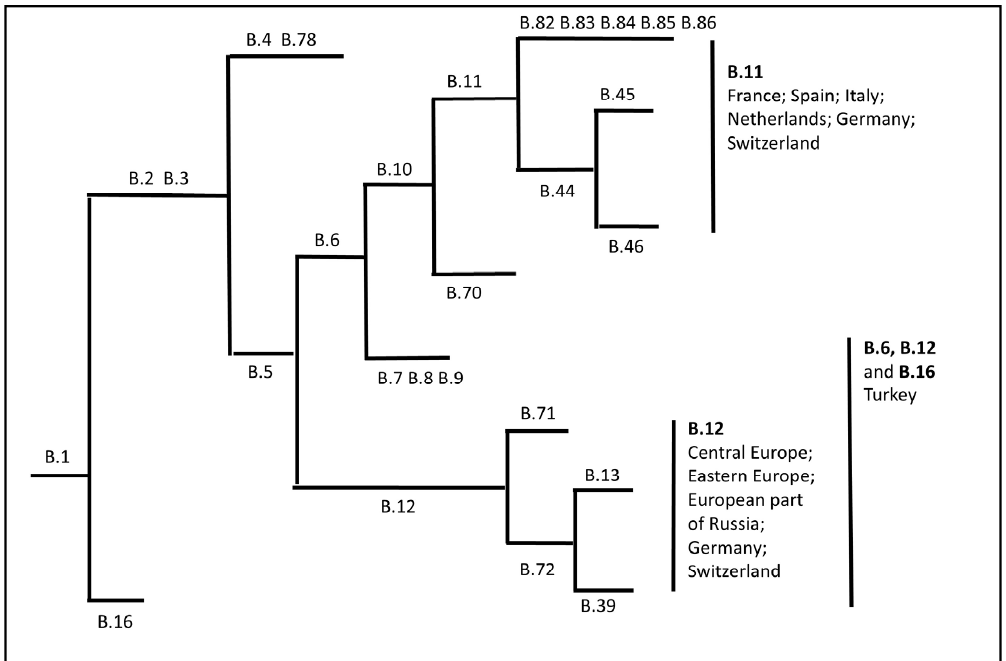
Figure 1. Schematic diagram of phylogeny of F. tularensis subsp. holarctica according to canonical